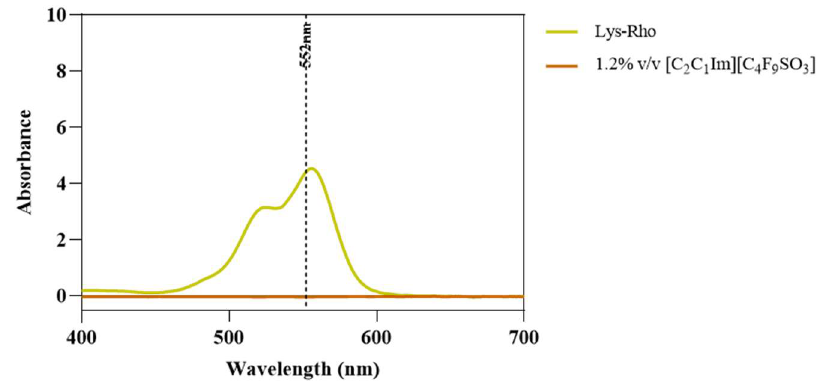
Figure 13. Lys-Rho absorbance spectrum compared to 1.2% v / v [C 2 C 1 Im][C 4 F 9 SO 3 ]. Vertical line marks Rho λ exc (552 nm).